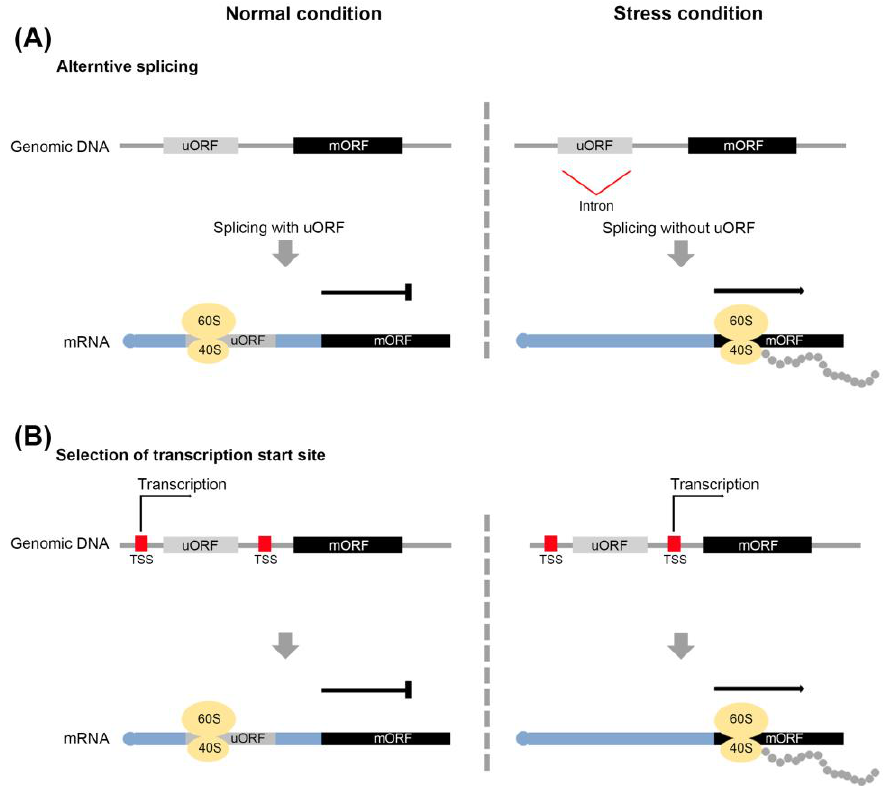
Figure 3. Mechanism of avoiding uORF-mediated repression of gene expression. Alternative splic- ing ( A ) and alternative transcription start site (TSS) ( B ) to exclude a uORF from mRNA.